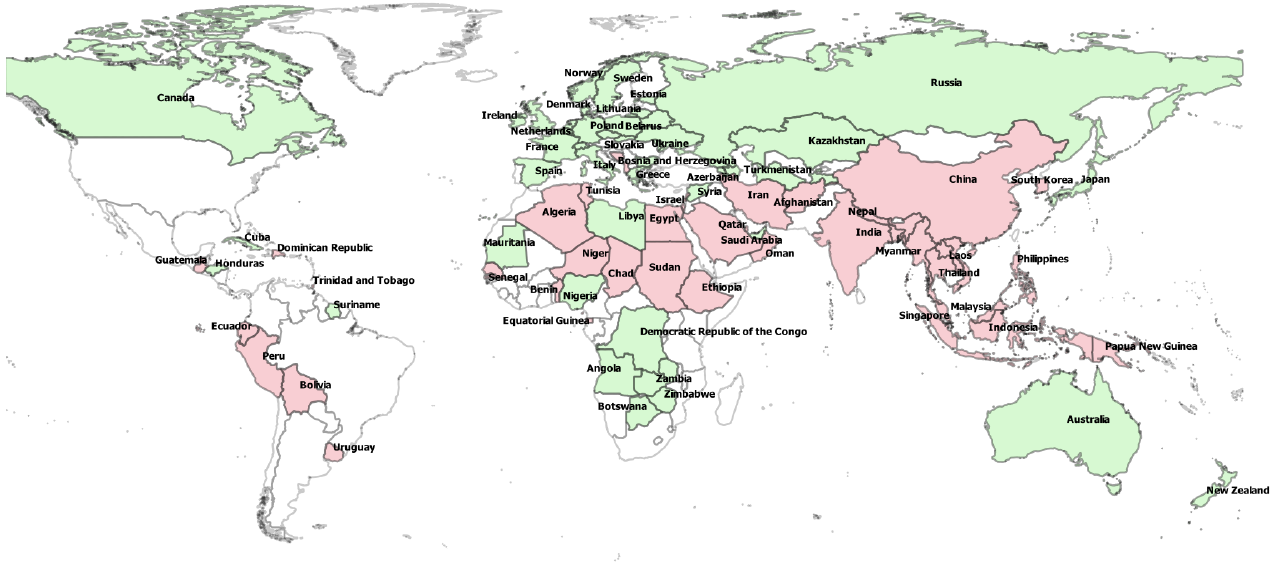
Figure 7. The world map of countries that have changed their emission systematically. The red color stands for systematic emission increase , the green color denotes systematic emission decrease, and the white color means no systematic